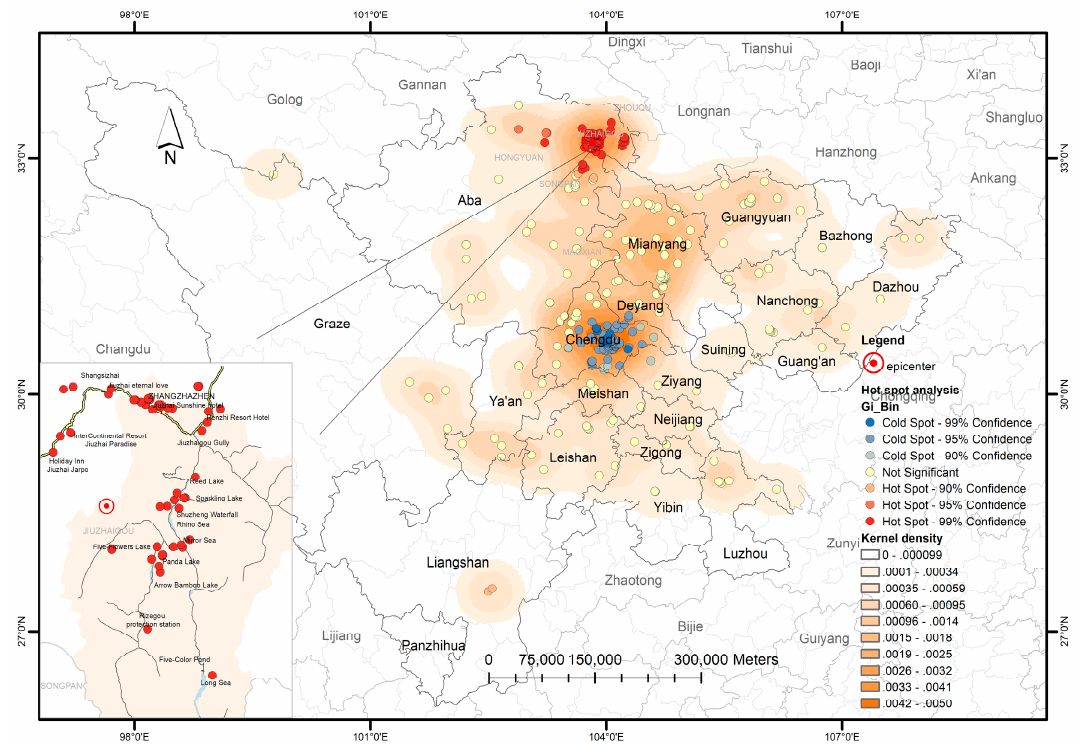
ISPRS Int. J. Geo-Inf. 2019 , 8 , x FOR PEER REVIEW Figure 4. 24-h hot spot analysis and kernel density of microblogs. Figure 4. 24-h hot spot analysis and kernel density of microblogs.